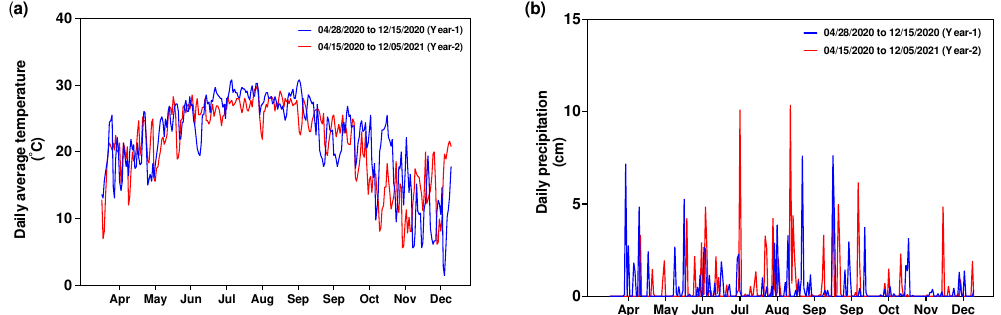
Figure 1. Daily average temperature ( a ) and precipitation ( b ) from cover crop seeding to harvest of the tomato crop. Data were obtained from the Climatology Office of the South Carolina State Department of Natural Resources.